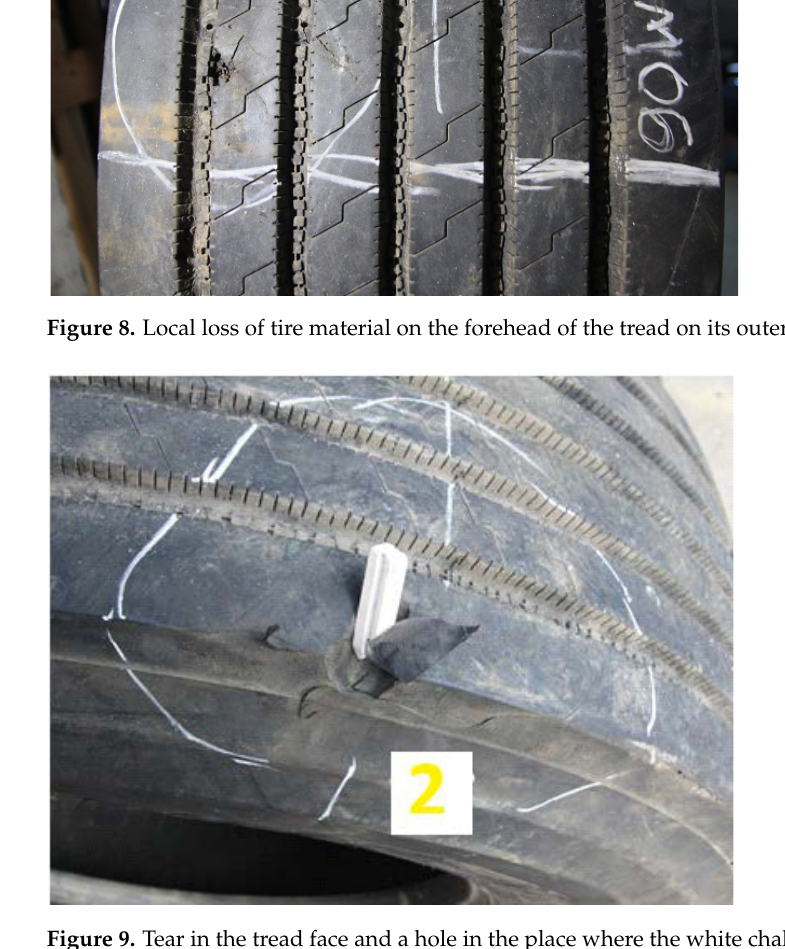
Figure 9. Tear in the tread face and a hole in the place where the white chalk is placed. Damage in the form of deformed edges was found on both sides of the wheel rim, while the extent of deformation on the outer side was greater than on the inner side. The deformation of the rim on the outer side was (during the post-accident inspection) on the side opposite to the crack in the tire sidewall; Figure 10. Relating the location of the damage to the wheel rim on its outer side to the damage to the tire, it was found that the local material loss on the tread face (Figure 8) was on a plane perpendicular to the side of the wheel and passing through the place of maximum deformation of the rim edge. The deformation of the wheel rim on its outer side can be explained as a result of a collision with Car A with which the wheel first came into contact or as a result of the wheel contacting with deformed parts of the truck’s shell, e.g., cab steps, which were deformed and disintegrated as a result of successive impacts to the vehicle. It was assumed that the point of application of the force resulting from an impact is at the point of maximum deformation of the rim. This point is, therefore, on the opposite side of the circumference and on the opposite side of the wheel, where the tire sidewall fracture (which was found on the inside) was